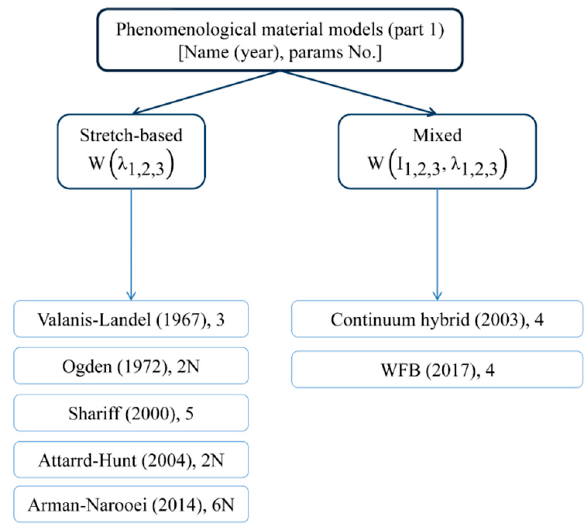
Figure 1. Different phenomenological models of hyper-elastic materials (part 1).